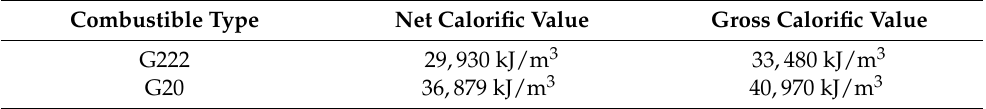
Table 3. Net and gross calorific values.